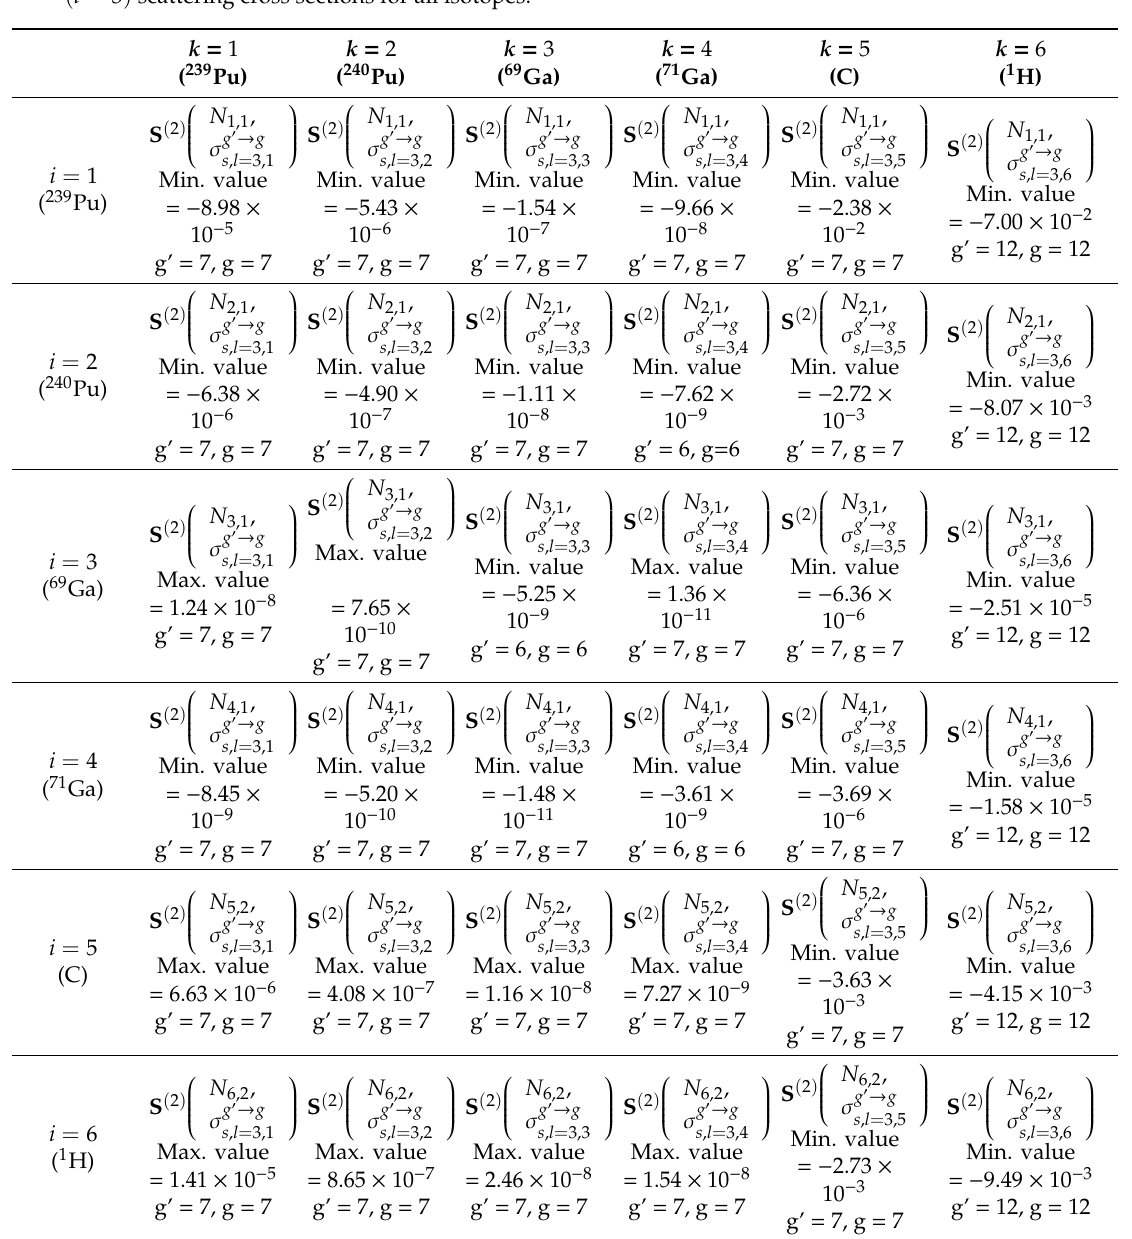
(cid:16) (cid:17) (cid:48) → g N i , m , σ g , comprising the 2nd-order relative s , l = 3, k